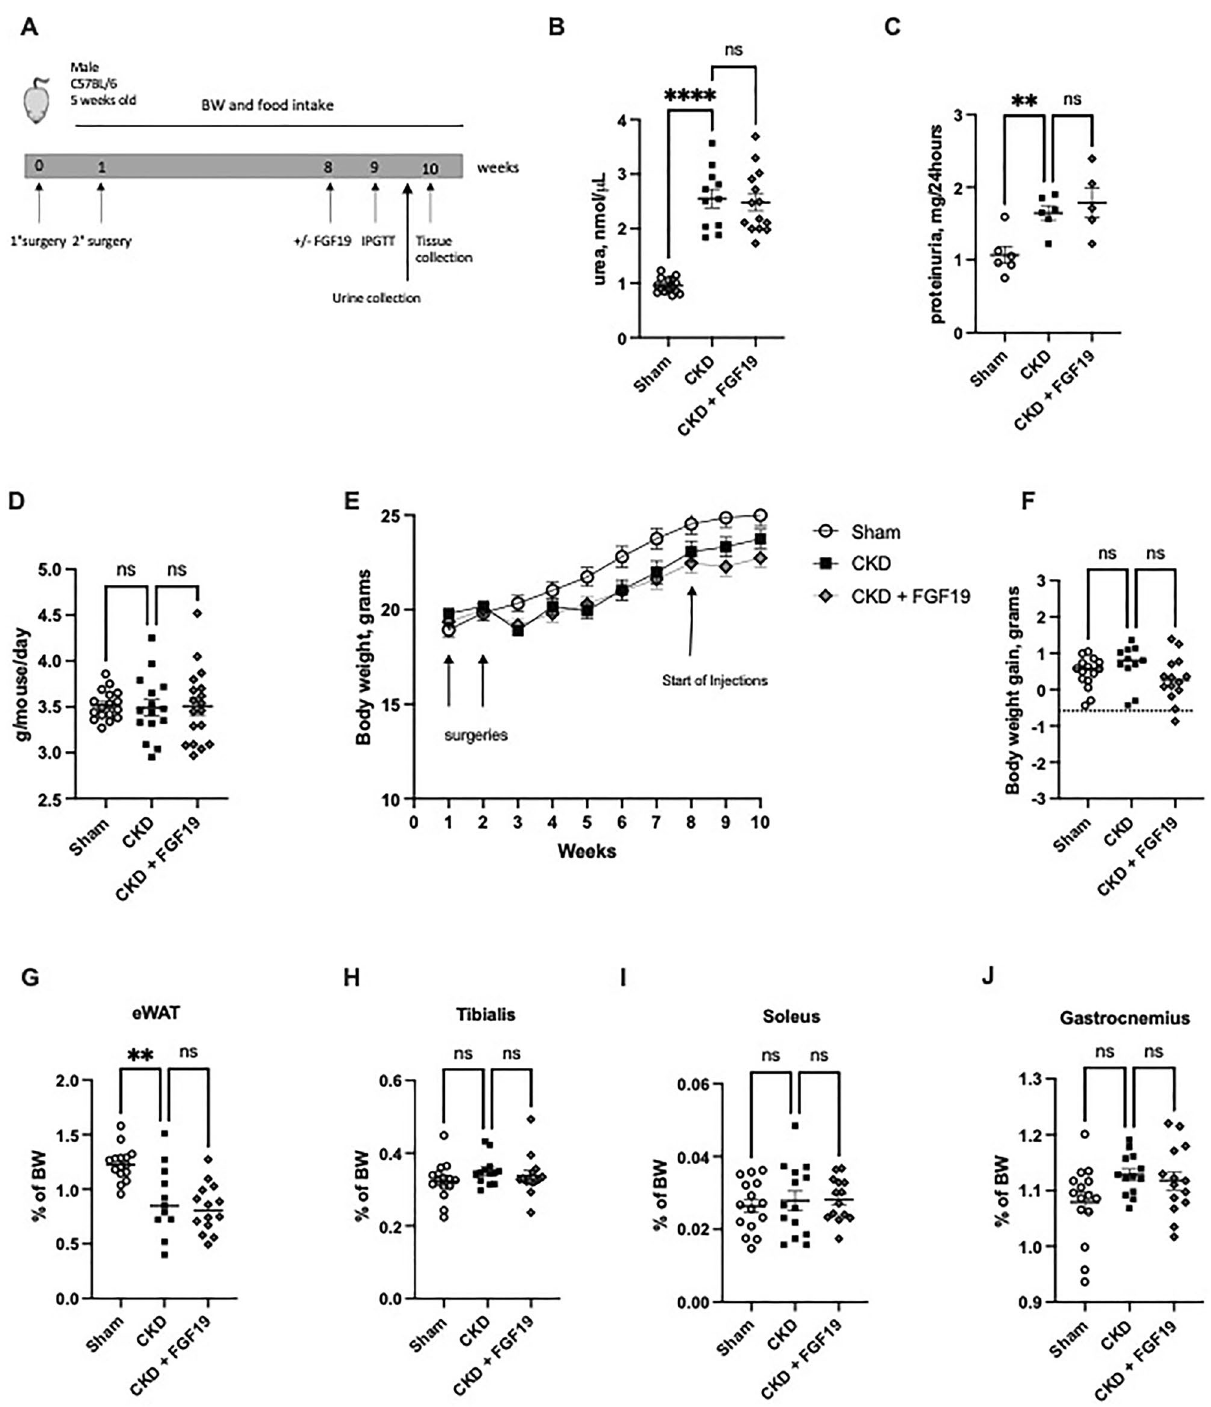
Figure 1. FGF19 treatment does not modify food intake and body composition in uremic mice. CKD mice induced by 5/6 nephrectomy or Sham mice were treated with 0.1 mg/kg body weight of FGF19 or with vehicle during 18 days. ( A ) Experimental timeline. ( B ) Blood urea. ( C ) 24 h proteinuria. ( D ) Daily food intake. ( E ) Body-weight evolution. ( F ) Body-weight gain. ( G ) Weight of epididymal WAT. ( H ) Weight of tibialis anterior, and ( I ) Weight of soleus ( J ) Weight of gastrocnemius after FGF19 or vehicle injection. n = 13–15 mice per group expected for proteinuria (n = 5–6). Data are mean ± SEM. Statistical analysis was done using a one-way ANOVA test. *P < 0.05, **P < 0.01, **** P < 0.0001. Abbreviation: BW: body weight, CKD: chronic kidney disease., n.s., not significant; WAT: white adipose